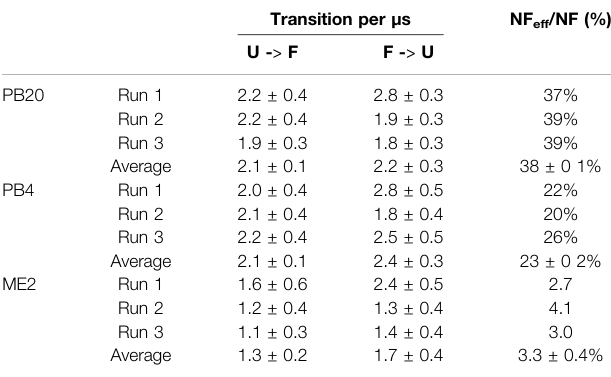
TABLE2| ForeachreplicateofthePB20,PB4,andME2simulationsarereported: 1) the number of transitions per microsecond from the folded (F) to the unfolded (U) state and vice versa; 2) the percentage of the effective frames, NF eff , over the total number of frames ( NF